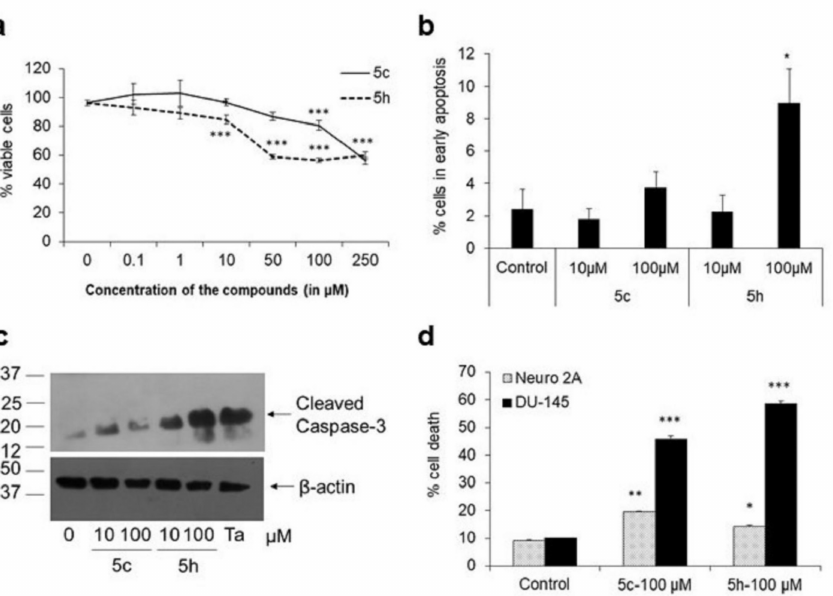
Figure 2. Substituted imidazo[1,2- b ]pyridazine compounds show differential cytotoxicity. ( a ) IMR- 32 cells were stimulated with compounds 5c and 5h at different doses for 24 h followed by MTT assay. Relative viability of the cells in comparison to control (set to 100%) is depicted. Only vehicle (DMSO) is used at concentration 0. Eight wells per condition were used and at least four independent experiments were conducted. *** p < 0.001, with respect to untreated cells. Error bars represent SEM. ( b ) Cells treated with compounds 5c or 5h for 24 h were stained with PI and Annexin V and analyzed on a flow cytometer. The percentage of total cells that were PI negative and Annexin V positive are depicted here as cells in early apoptosis. * p < 0.05, with respect to untreated cells. Error bars represent SEM, n = 4. ( c ) IMR-32 cells treated with 10 or 100 µ M compound 5c or 5h were harvested after 24 h for analysis of cleaved caspase 3 levels through Western blot. As a positive control, cells were also stimulated with 250 µ M TaClo, which is known to activate caspase 3 in neuroblastoma cells. ( d ) The mouse neuronal cell-line, Neuro-2A, and the human prostate cancer cell line, DU-145, were treated with 100 µ M compound 5c or 5h for 36 h. Cells were then stained with PI and viable cells analyzed on a flow cytometer. * p < 0.05, ** p < 0.01, *** p < 0.001, with respect to control cells. Error bars represent